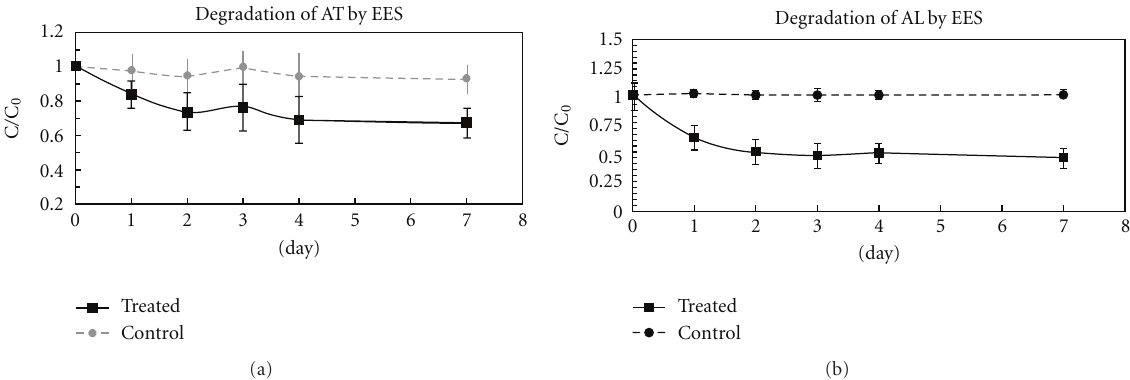
Figure 5: Disappearance of AT and AL over time from biometers of the EES degradation study. Data are the means of triplicate experiments. Error bars represent ± 1 standard deviation. (a) Atrazine concentration (C) is initialized and expressed as a fraction of the initial concentration (C 0 ). (b) Alachlor concentration (C) is initialized and expressed as a fraction of the initial concentration (C 0 ).